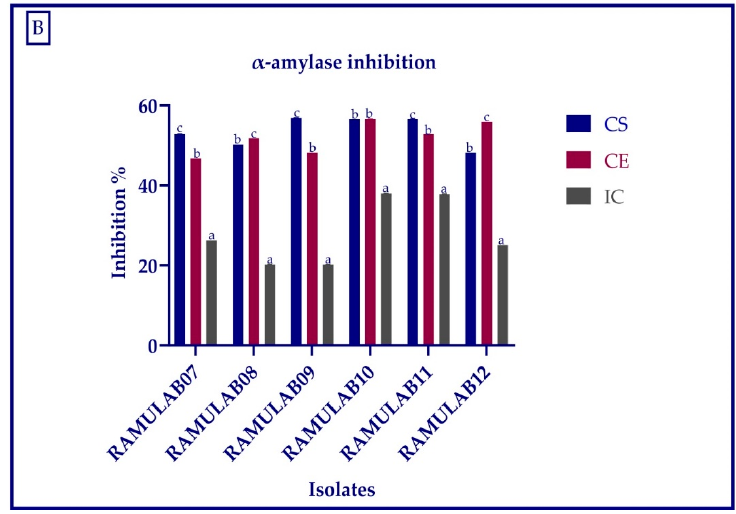
Figure 7. α -glucosidase ( A ) and α -alpha amylase ( B ) inhibitory activity of the isolates. Data are expressed as the mean ± SD. Means in inhibition activity of CS, CE, and IC with distinct superscripts (a–c) are significantly different ( p ≤ 0.05), as separated by Duncan multiple range test.